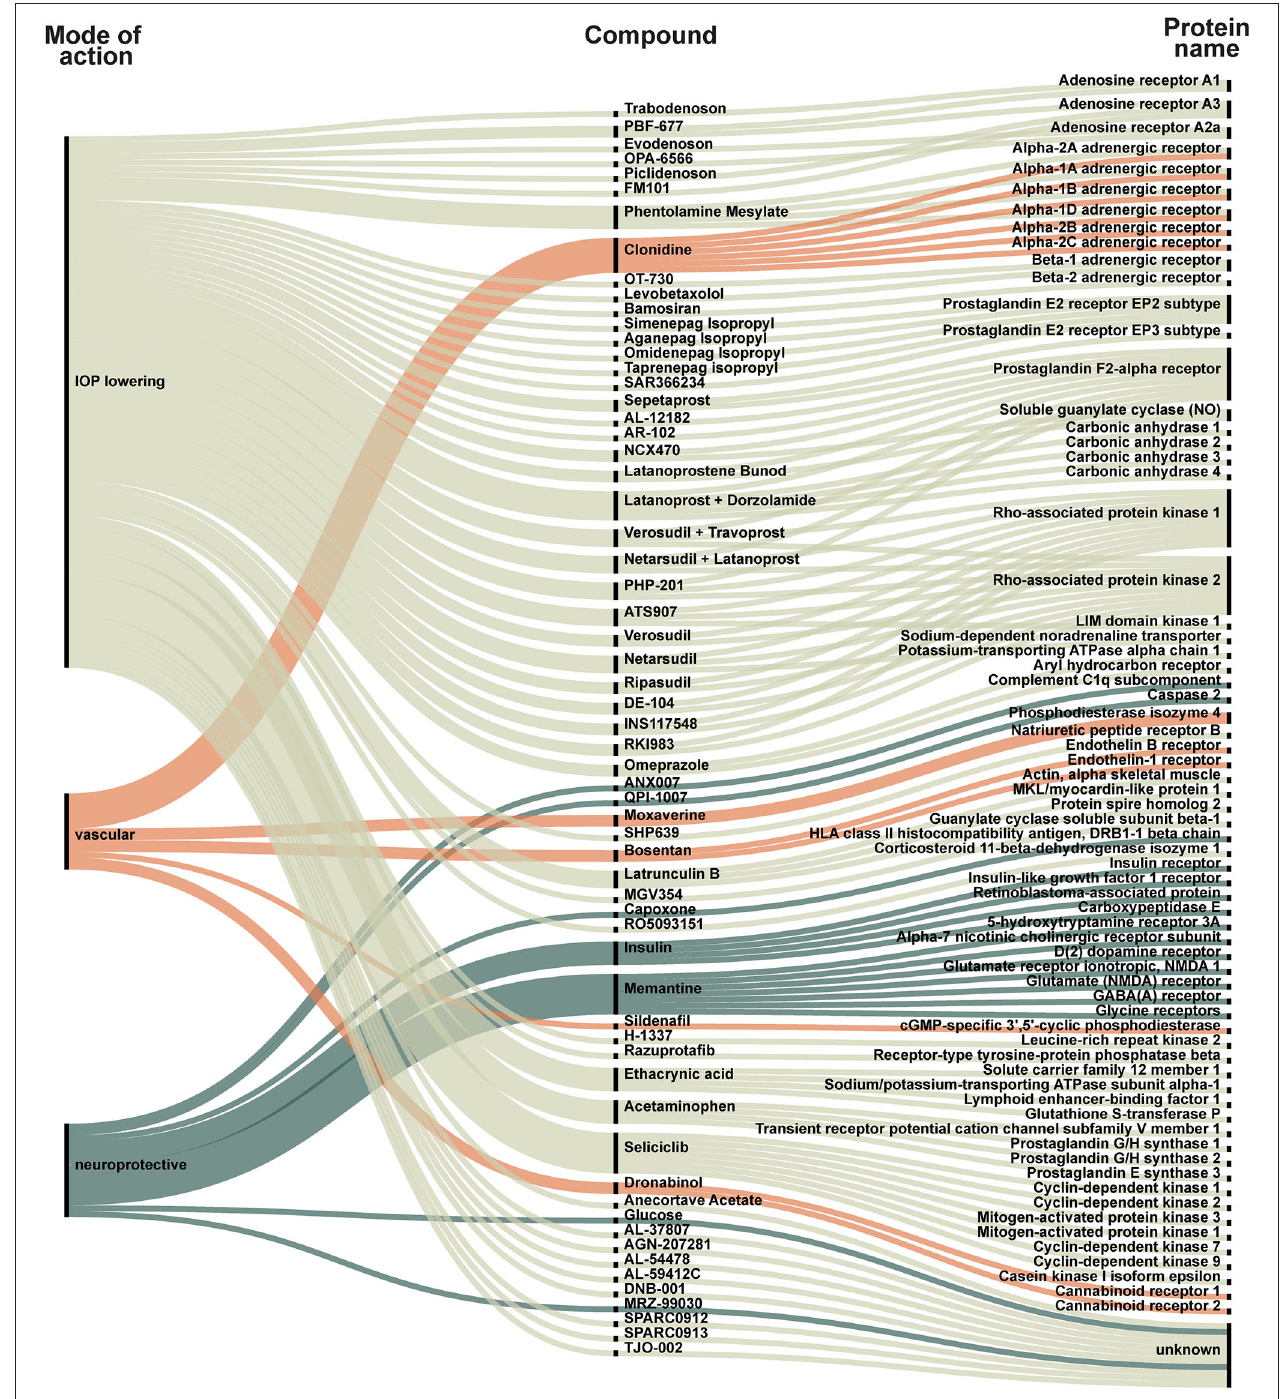
FIGURE 2 | New compounds represented in all included trials. Each compound is categorized as IOP-lowering (light green), vascular (orange) or neuroprotective (dark green). The compound is linked to its target. The targets are listed to the right and visualize how some compounds act on several targets. For example: (1) Trabodenoson is an IOP-lowering compound that targets adenosine receptor A1; (2) Clonidine is a vascular compound targeting six different alpha-adrenergic receptors (1A, 1B, 1D, 2A, 2B, and 2C); (3) Insulin is a neuroprotective compound that acts on insulin receptor, insulin-like growth factor 1 receptor, retinoblastoma-associated protein, and carboxypeptidase